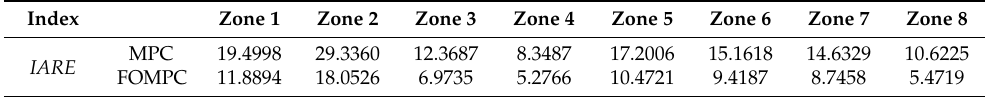
Table 2. Indices for IARE in reference tracking